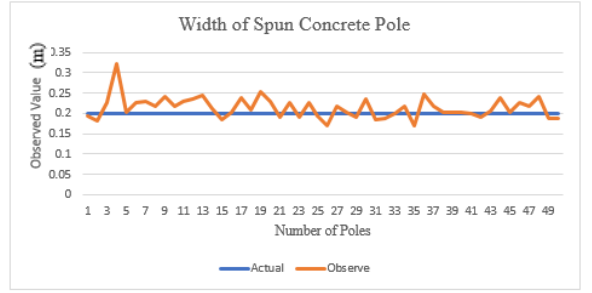
Figure 14 . The Width of Concrete Pole